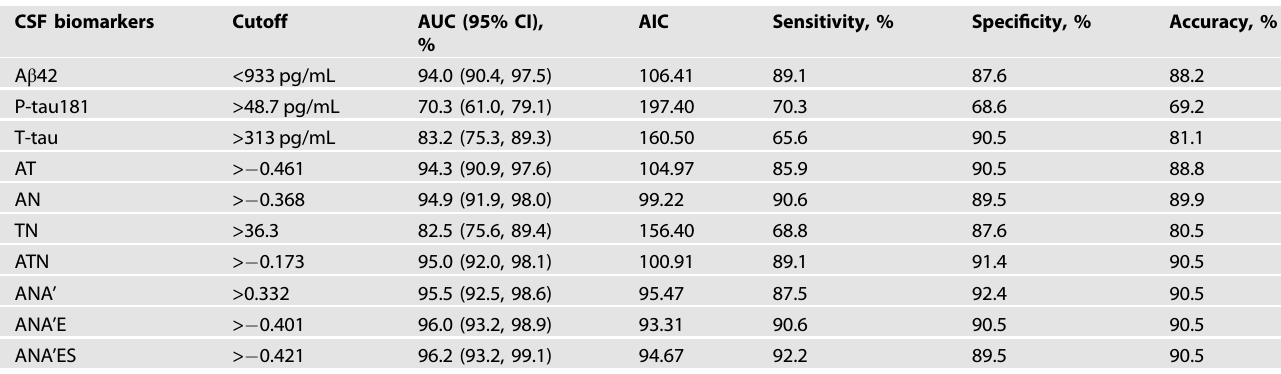
Table 2. Performance of CSF biomarker